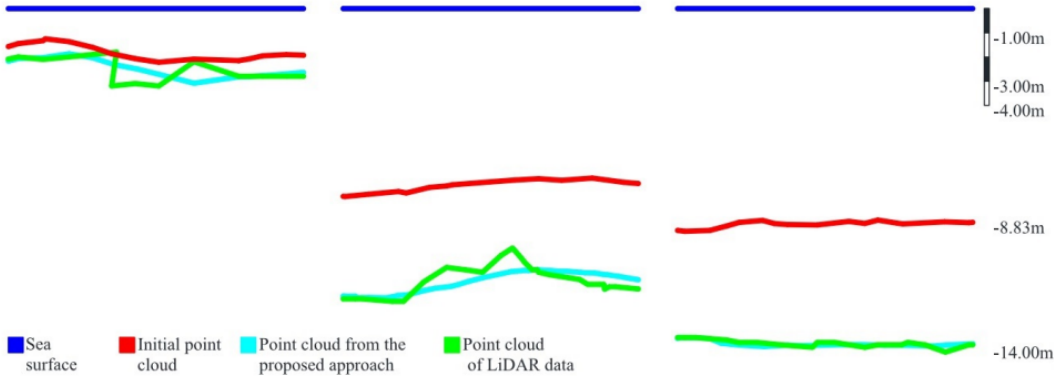
Figure 3. Data comparison between point cloud obtained from bathymetric Light Detection And Ranging (LiDAR) measurements (marked by green lines) and processed SfM point cloud (marked by red lines) by the Support Vector Regression (SVR) algorithm (marked by sky-blue lines). Water surface is also indicated by a blue line [29].